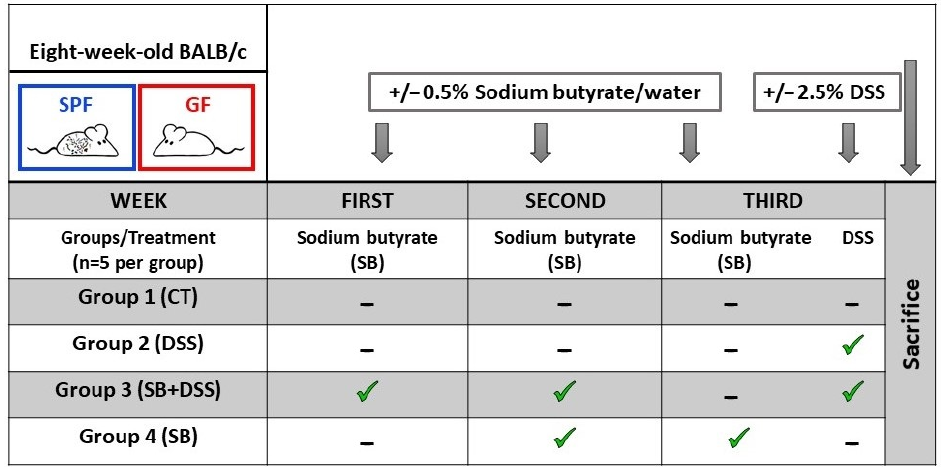
Figure 3. Experimental design. Both SPF (n = 20) and GF (n = 20) mice were subdivided into 4 equal groups. Healthy control mice (group 1, CT) were without any treatment. DSS mice (group 2, DSS) were without SB treatment only with induced colitis by one ‐ week DSS administration. In the third group, SB was administered for two weeks at the “preventive” setting and subsequently, colitis was induced by one week of 2.5% DSS administration (group 3, SB + DSS). In the last group, mice received SB solution for two weeks (group 4, SB) before sacrifice.